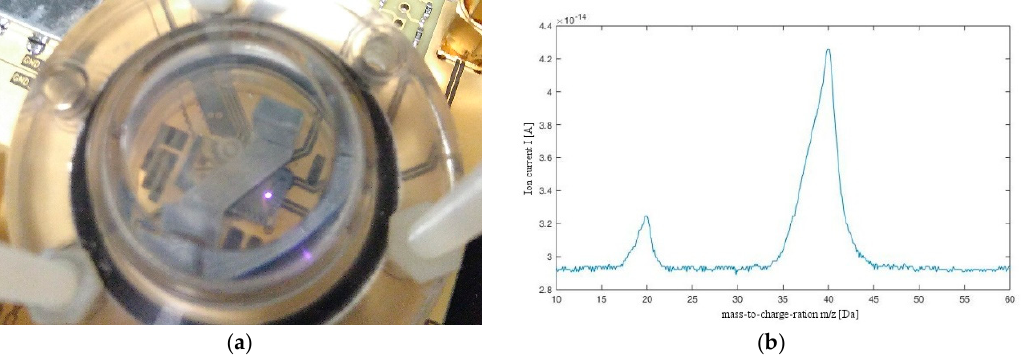
Figure 3. ( a ) Mounted MEMS-chip in vacuum chamber in operation; ( b ) Mass spectrum with Argon as plasma and sample